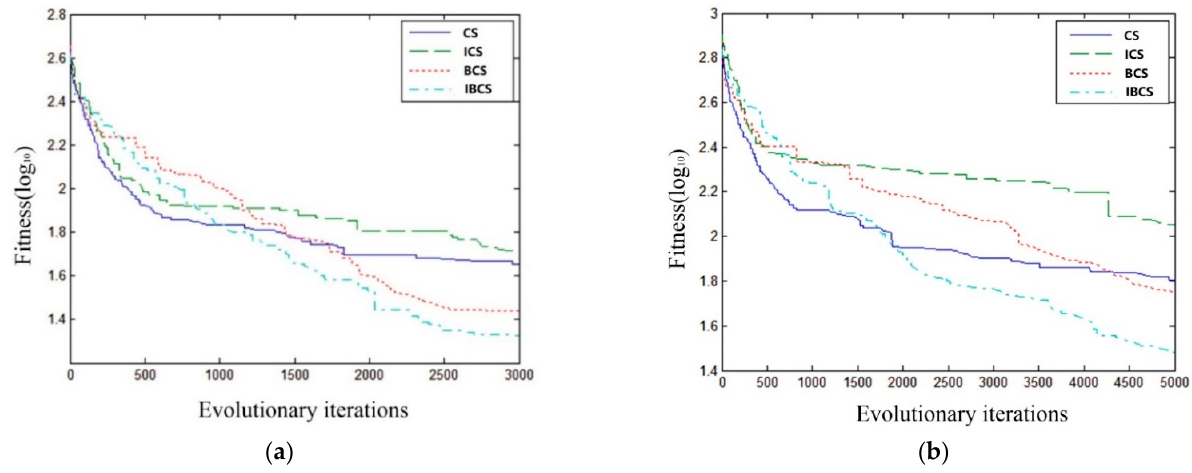
Figure 7. Comparison of convergence results of the Rastrigin function; ( a ) 30-dimensional; ( b ) 50-dimensional.